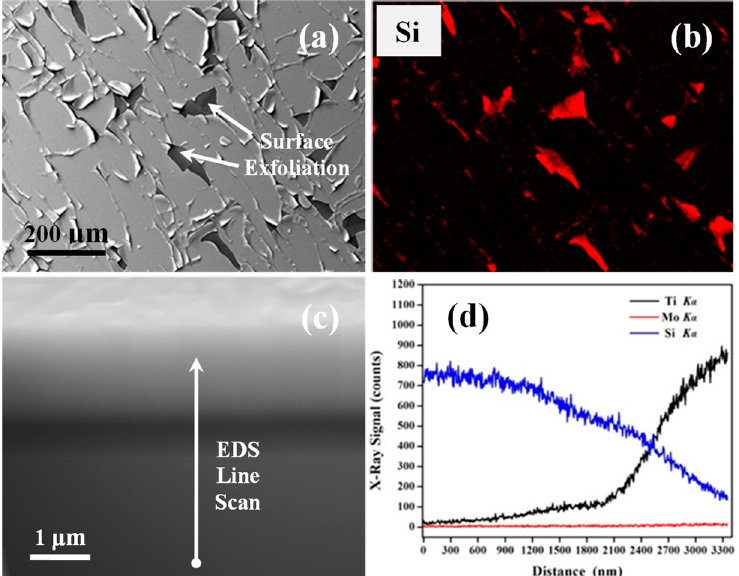
Figure 4. (Color online) ( a ) SEM image of Mo-8a sample taken from the delamination area and ( b ) the Si element distribution in (a). ( c ) Cross-sectional SEM image obtained from Mo layer absent area and ( d ) energy dispersive spectroscopy (EDS) line scan of Ti, Mo, and Si elements along Line 1 in (c).